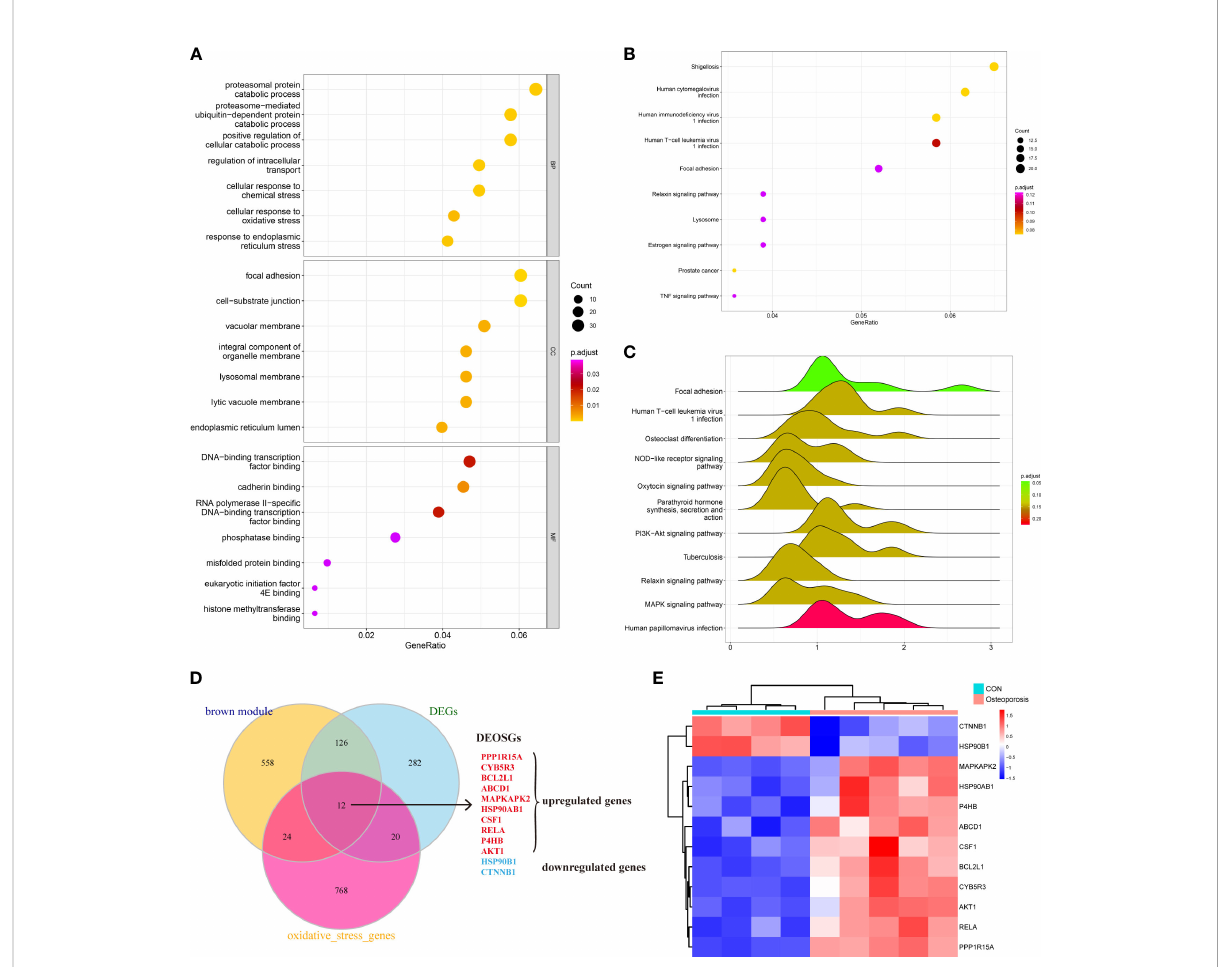
FIGURE 3 (A – C) Understanding the functional and pathway enrichment analysis of genes in the brown module. (D) Venn plot suggested that 12 genes were determined as the hub differentially expressed oxidative stress genes (DEOSGs) of osteoporosis (OP). (E) Heatmap of the expression patterns of these